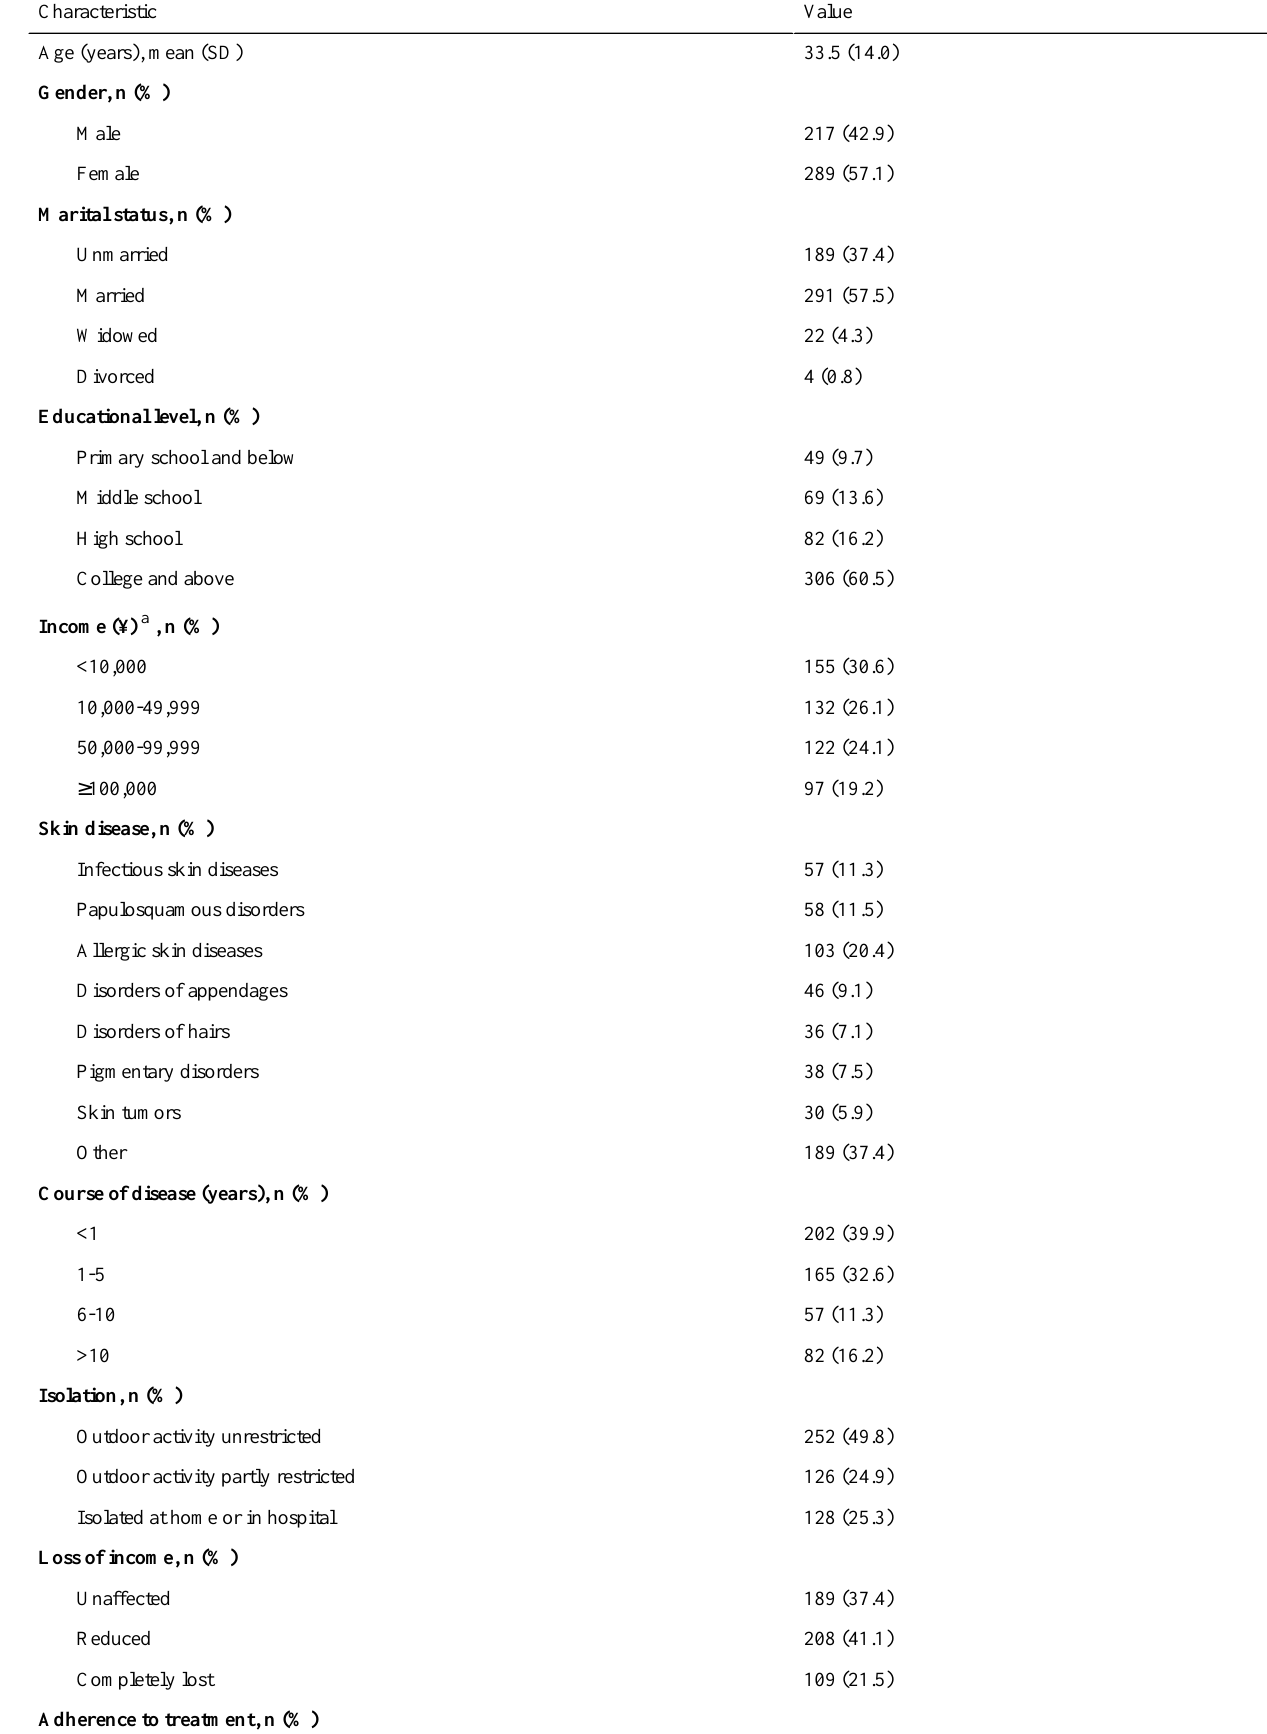
Table 1. Characteristics of the participants